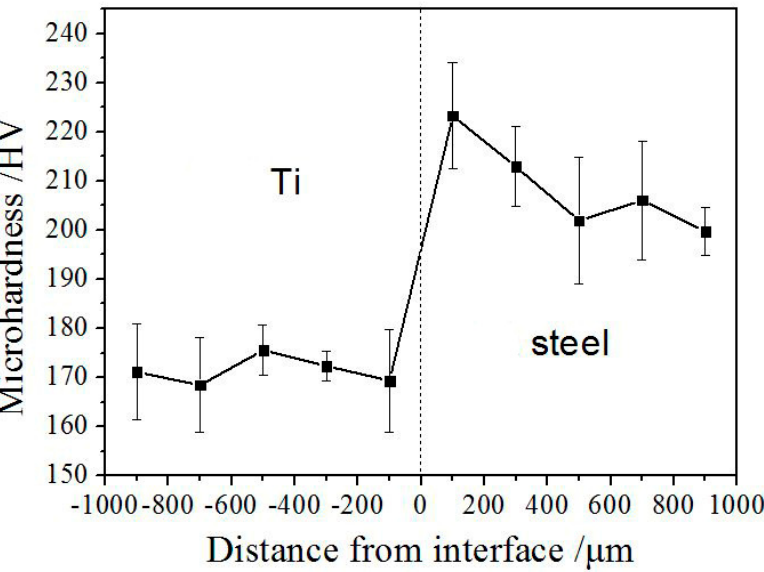
Figure 7. Microhardness profile across the TA1/LAS bonding interface after explosive welding.